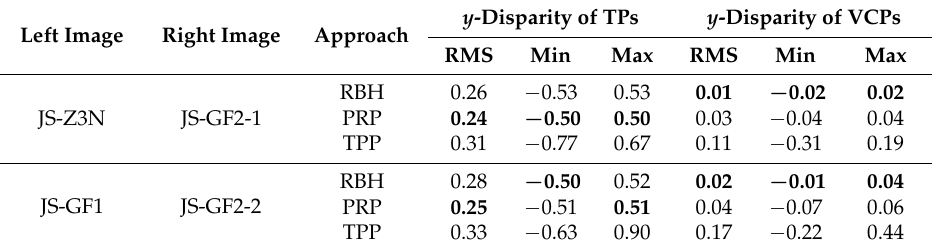
Table 2. The results of the image pairs in the cross-track coplanar stereo condition.